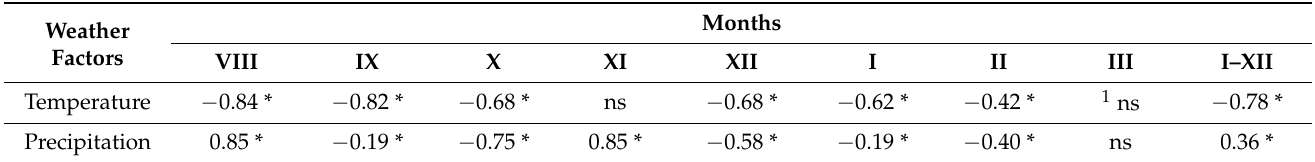
Table 5. Correlation coefficients between temperatures ( ◦ C) and precipitation (mm) in months after fruit harvest in 2018–2022 and the production of tested biotypes and cultivars of Elaeagnus multiflora in the following